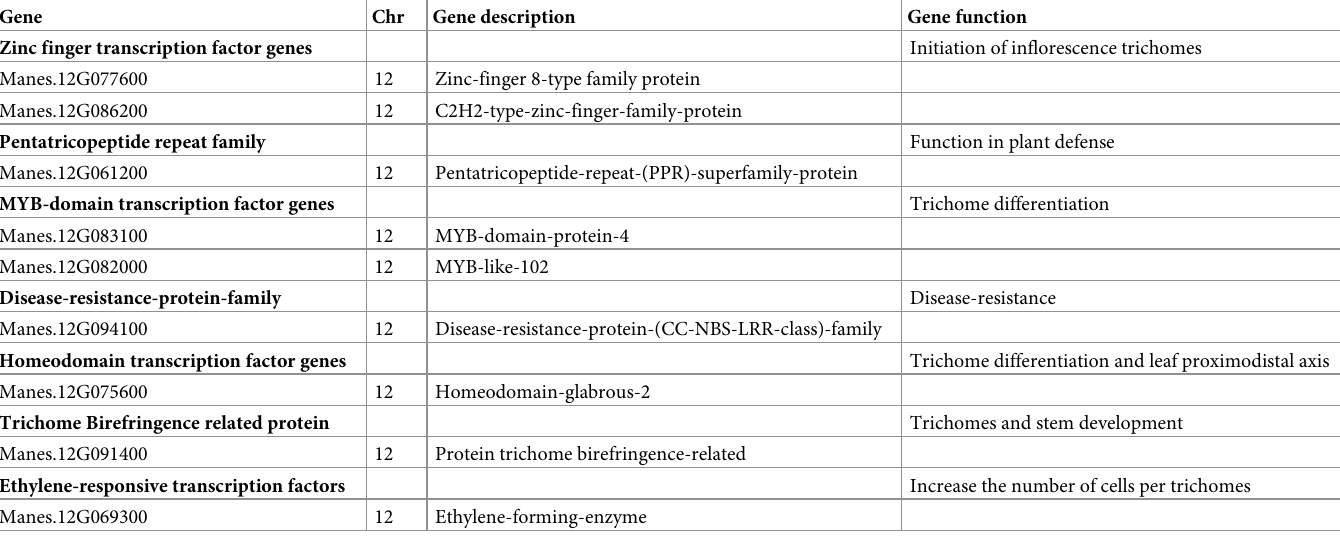
Table 3. Candidate genes associated with CGM resistance.